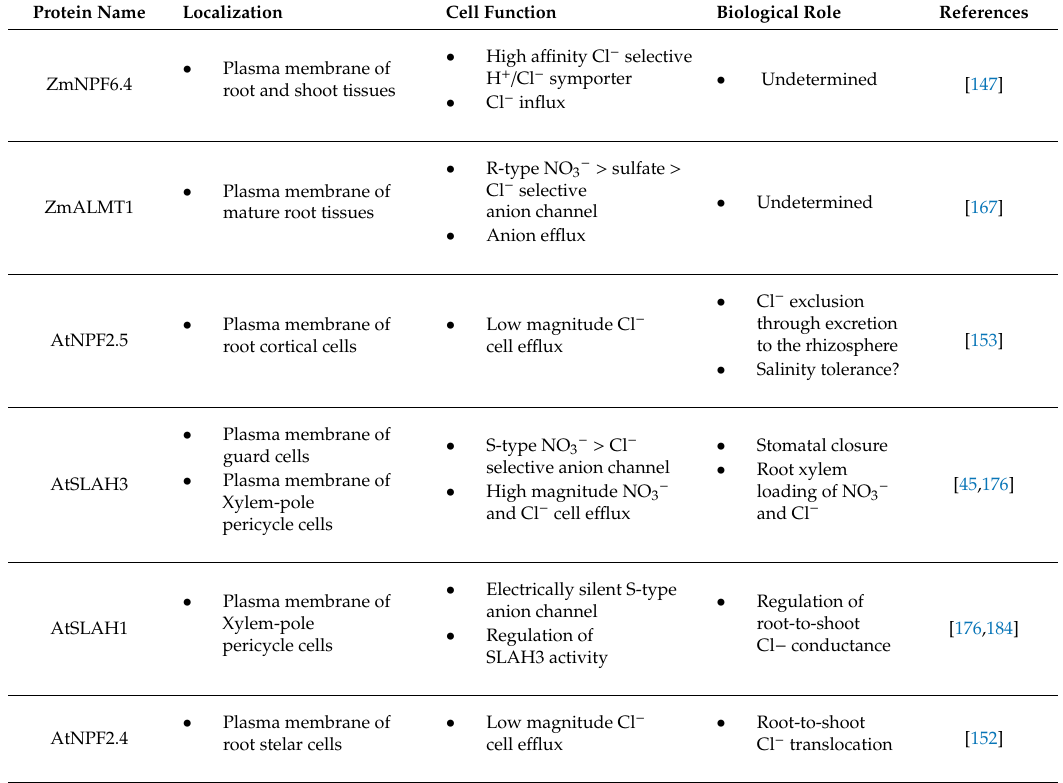
Table 3. Functional properties of Cl − transport proteins potentially involved in Cl − nutrition: net uptake and / or long-distance